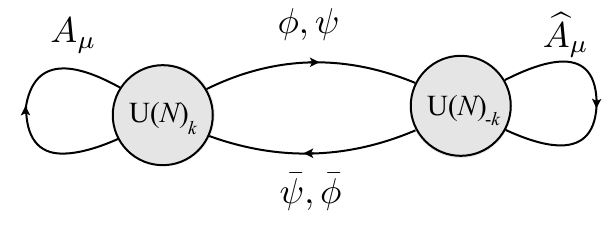
Figure 1 . Quiver diagram for the ABJM